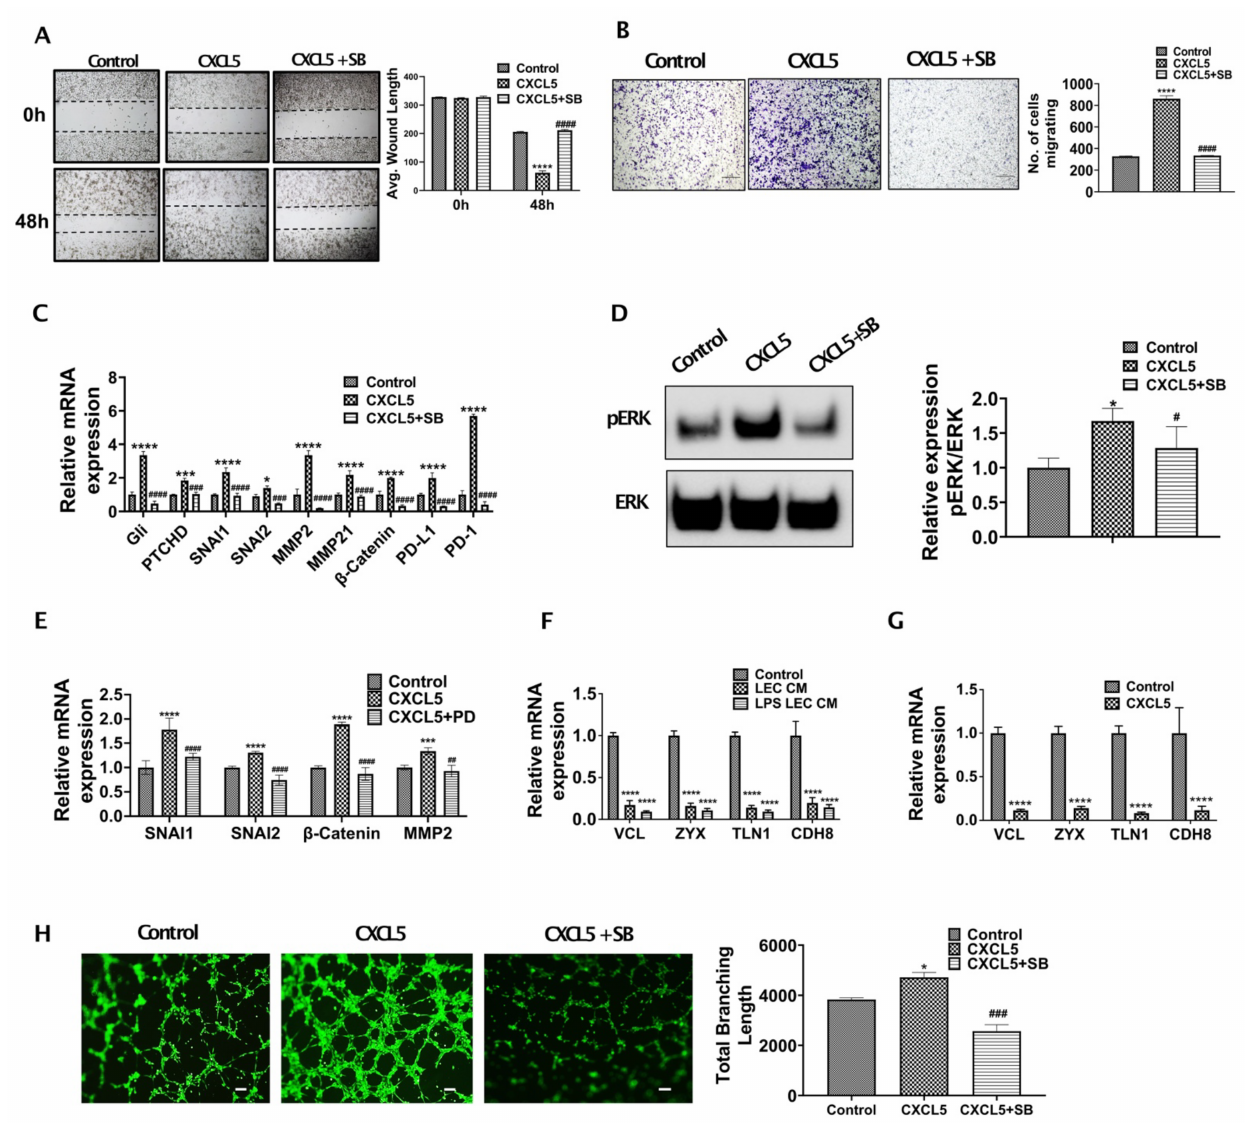
Figure 4. CXCL5 induces critical EMT associated genes in CCA and also enhance lymphangiogenesis. ( A , B ) CXCL5 induces increased migration of CCA cells. ( A ) CCA cells were pretreated with or without CXCR2 inhibitor, SB225002 (denoted as SB). A scratch was made on the confluent monolayer. The cells were then treated with CXCL5, and the average wound length was monitored for 48 h. Representative images at 4 × magnification are shown. Values are represented as mean ± SEM, n ≥ 3. **** represents value significantly different than control group respectively at p ≤ 0.0001. #### represents value significantly different than CXCL5 treated group at p ≤ 0.0001. ( B ) CCA cells were pretreated with or without SB and were allowed to migrate towards CXCL5 in transwell inserts for 24 h. Representative images at 10 × magnification. Scale bars are 100 µ m. Number of cells migrated is plotted. **** represents value significantly different than control group respectively at p ≤ 0.0001. #### represents value significantly different than CXCL5 treated group at p ≤ 0.0001. ( C ) CXCL5 induces expression of EMT, matrix remodeling and immune checkpoint related genes in CCA. CCA cells were pretreated with or without SB and then with or without CXCL5 for 24 h. Expression of EMT, matrix remodeling and immune evasion related genes were measured by real time PCR. Values are represented as mean ± SEM, n ≥ 3. * p ≤ 0.05, *** p ≤ 0.001 **** p ≤ 0.0001 represents value significantly different than control group respectively. ### p ≤ 0.001 and #### p ≤ 0.0001 represents value significantly different than CXCL5 treated group at p ≤ 0.0001. ( D ) CXCL5-CXCR2 interaction activates ERK in CCA cells. CCA cells were pretreated with SB and then treated with CXCL5 for 24 h. Untreated groups were used as control. Expression of phospho-ERK and total ERK were measured by western blotting. Densitometric analysis was carried out. Graph represents relative band intensities of pERK/ERK. Values are represented as mean ± SEM, n ≥ 3. *